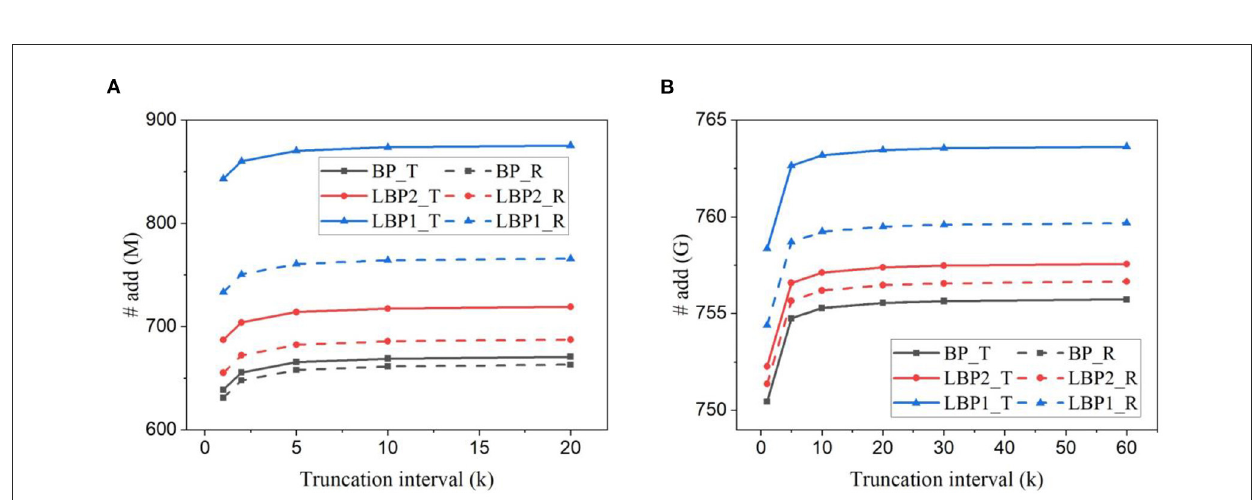
FIGURE11 Number of additions estimated for training (A) LeNet-1 on EMNIST dataset and (B) LeNet-2 on DvsGesture dataset for one batch iteration. The batch size is 128.